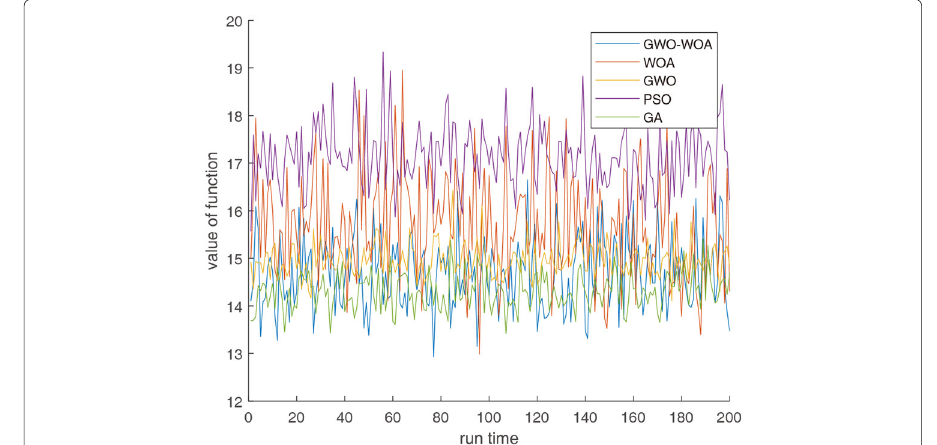
Fig. 2 The results of each run time of algorithms when device number is